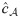
Robustness of the grid code with multiple modules.(a)-(b): Values of c^A estimated for 100 α randomly selected from the interval (1, 2) with M = 5 (a) and M = 10 (b) (see also Fig 5a for M = 2). The scales form a geometric series, i.e., A={αi}i=1M. Red circle indicates c^A for a second order algebraic number α = σ − 1/2 ≈ 1.118. Green (cyan) shows c^A for 5th (10th) order algebraic numbers, respectively. Noise level is the same as in Fig 5a (0.05 < δ < 0.2). (c)-(d): Mean (c) and coefficient of variation (d) of c^A evaluated on the range α = {1.1, 1.9}. For M = 10 the c^A is also shown for two alternative selection of the scales: if all 10 scales are selected randomly from the interval [1, 2] (olive) and when αs form a geometric series perturbed as A={(1+εi)αi}i=110, where εi are i.i.d. uniform random variables on the range [−0.01, 0.01] (purple). (e)-(f) Phase difference (ϵ^A(ℓ), Eq 25) in the function of the distance, ℓ. (e) Effect of number theoretic properties with M = 10. When α is the root of the 10th order polynomial x10 − x7 − 1, α ≈ 1.12725, ϵ(ℓ) decays as 1/ℓ1/9 (black). When α is second order, α = σ − 1/2 ≈ 1.11803, the initial decay is similar, but after a critical distance at ℓ ≈ 106 the decay becomes 1/ℓ (yellow). (f) The critical distance grows with the number of modules (αi = (σ − 1/2)i). Grey shading in (e-f) indicates the range of phase difference smaller than noise (Eq 26).